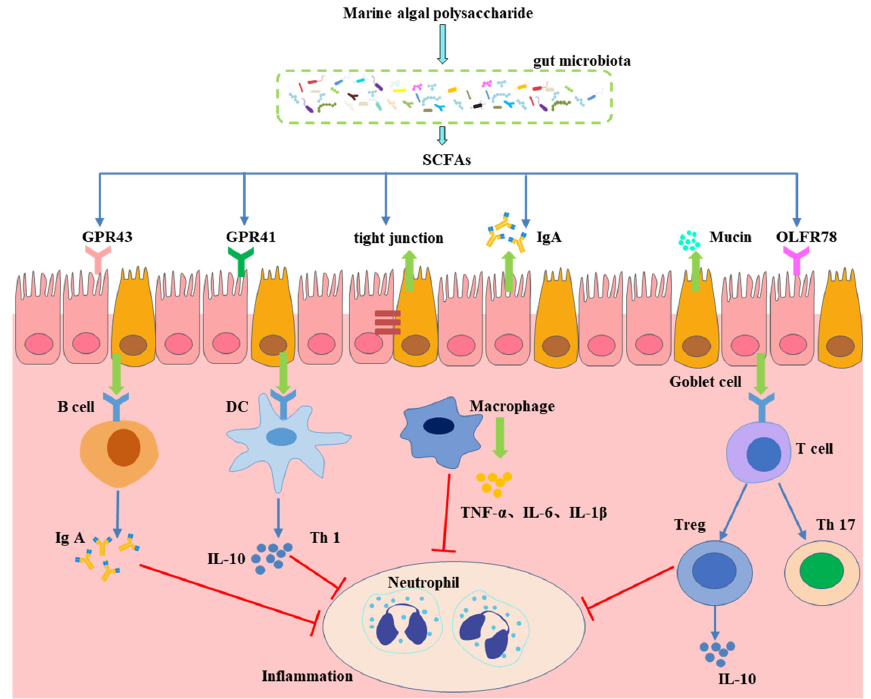
Figure 3. Functional impact of gut-derived SCFAs on host health. SCFAs are produced from the fermentation of MAP in the colon by gut microbiota.